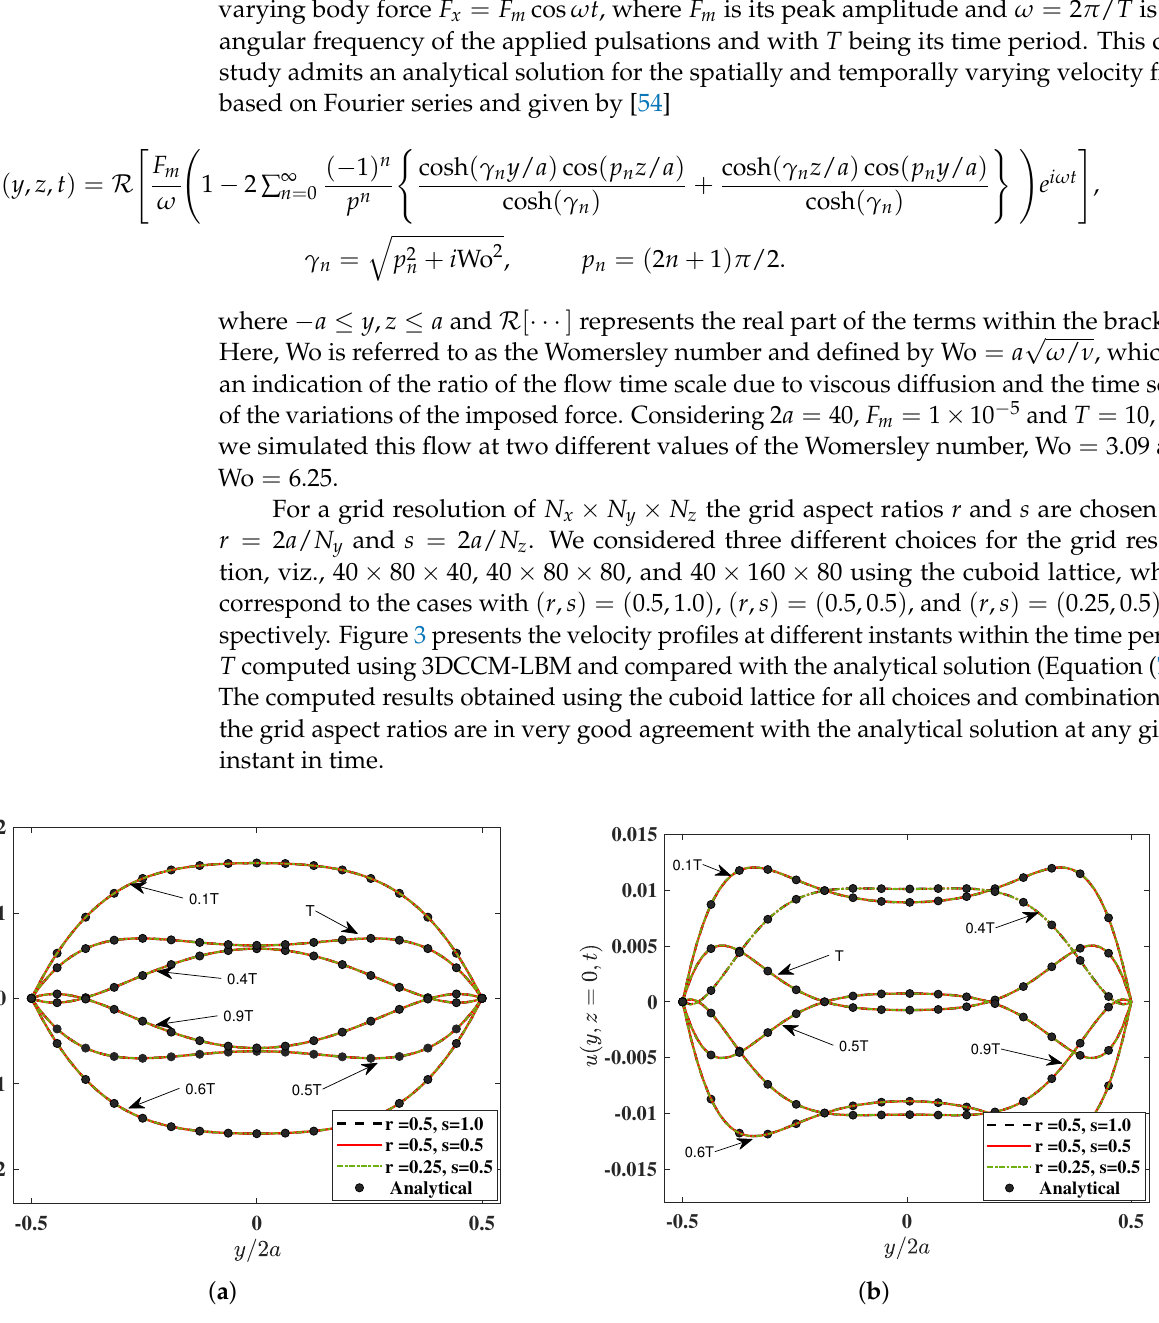
Figure 3. The velocity profiles for the pulsatile flow through a square duct at different instants within the time period T with Womersley numbers of ( a ) Wo = 3.09 and ( b ) Wo = 6.25 computed using 3DCCM-LBM (lines) with different aspect ratios ( ( r , s ) = ( 0.5,1.0 ) , ( r , s ) = ( 0.5,0.5 ) , and ( r , s ) = ( 0.25,0.5 ) ) compared with the analytical solution given in Equation (77)